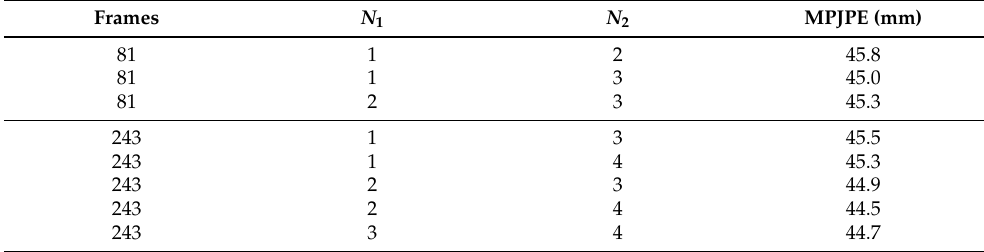
Table 5. Ablation study for our 81-frame and 243-frame model under protocol 1 on